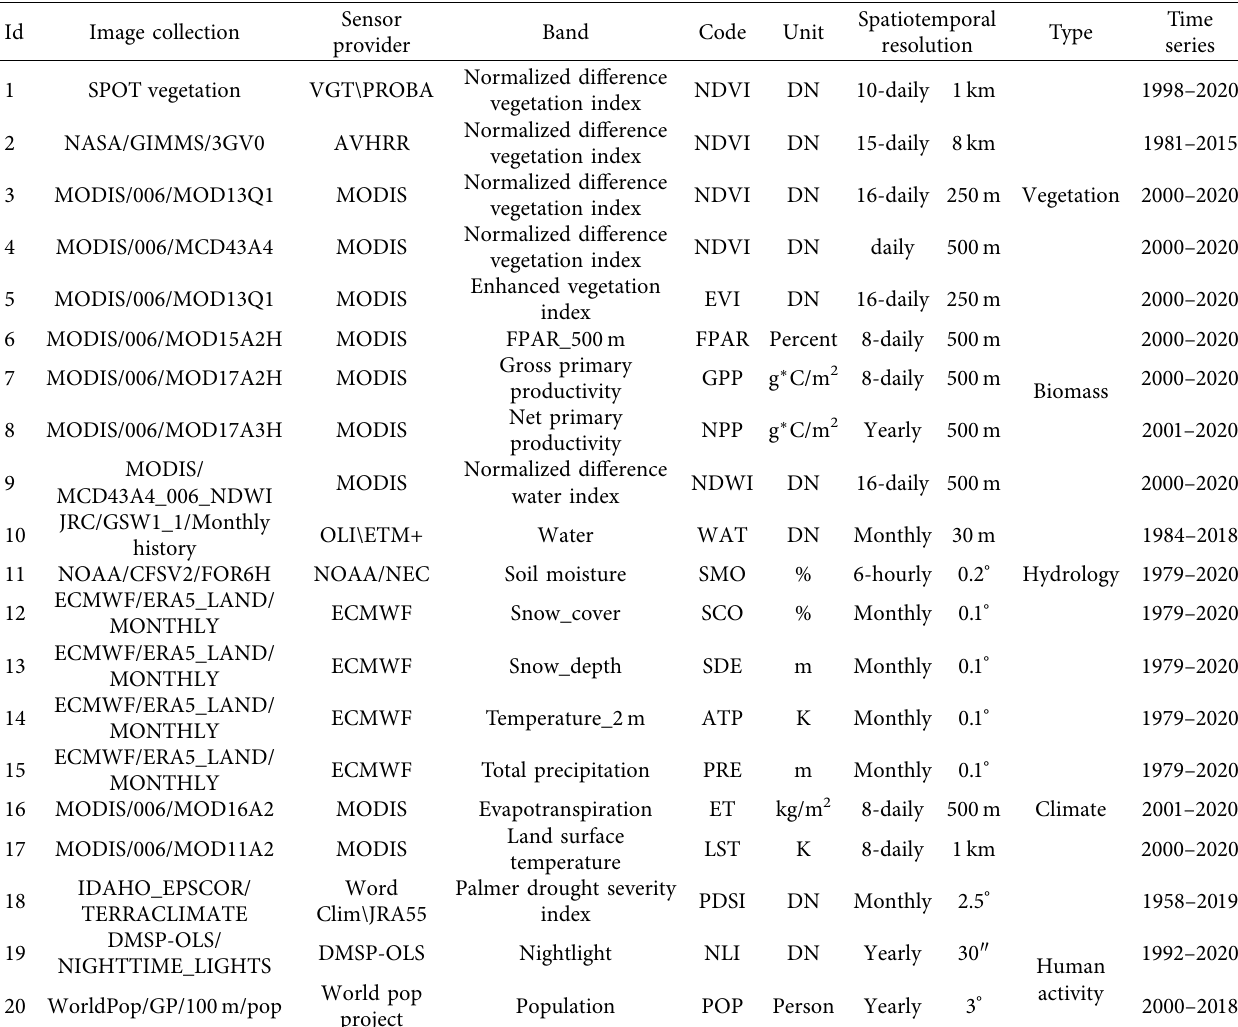
Table 1: Geospatial big data collection used in this